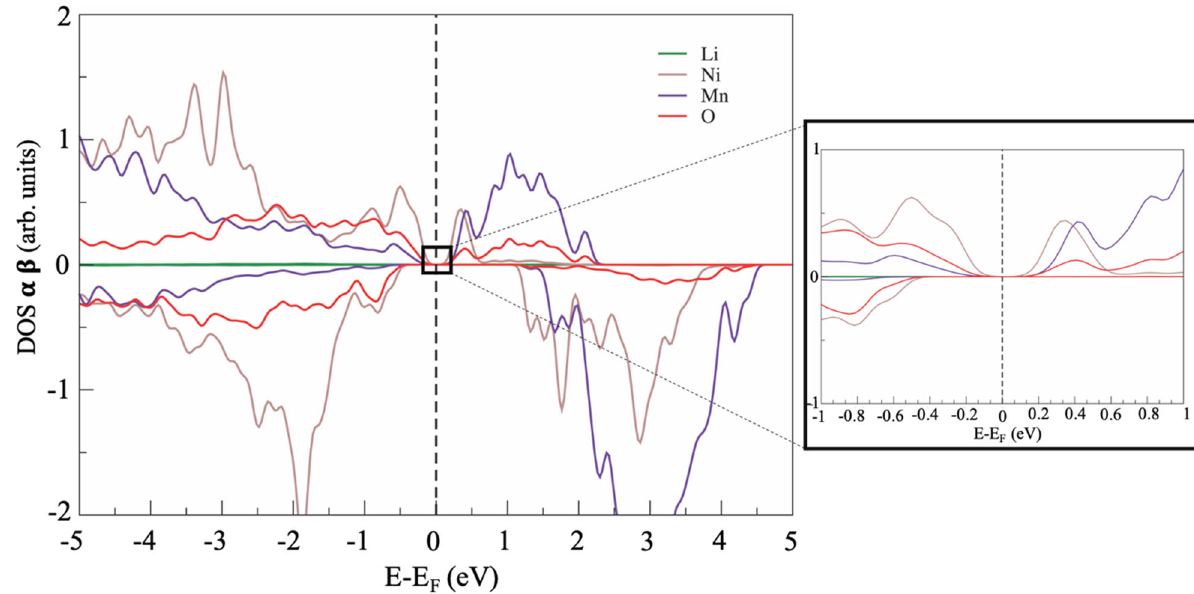
Figure 4. Example of the PDOS of LNM phase with antisite defect between Ni and Li.